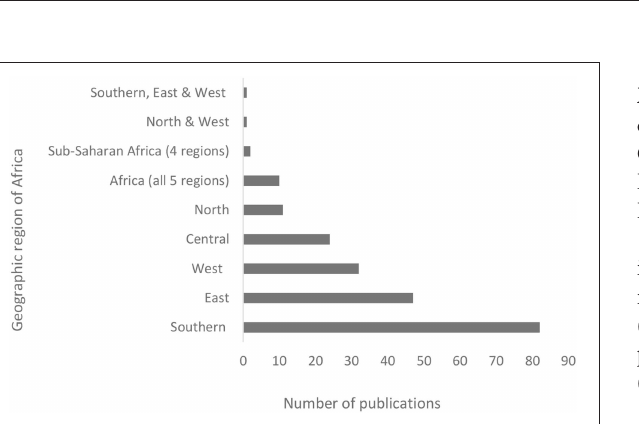
FIGURE 1 | The number of publications about road ecology in Africa between 1954 and 2016.